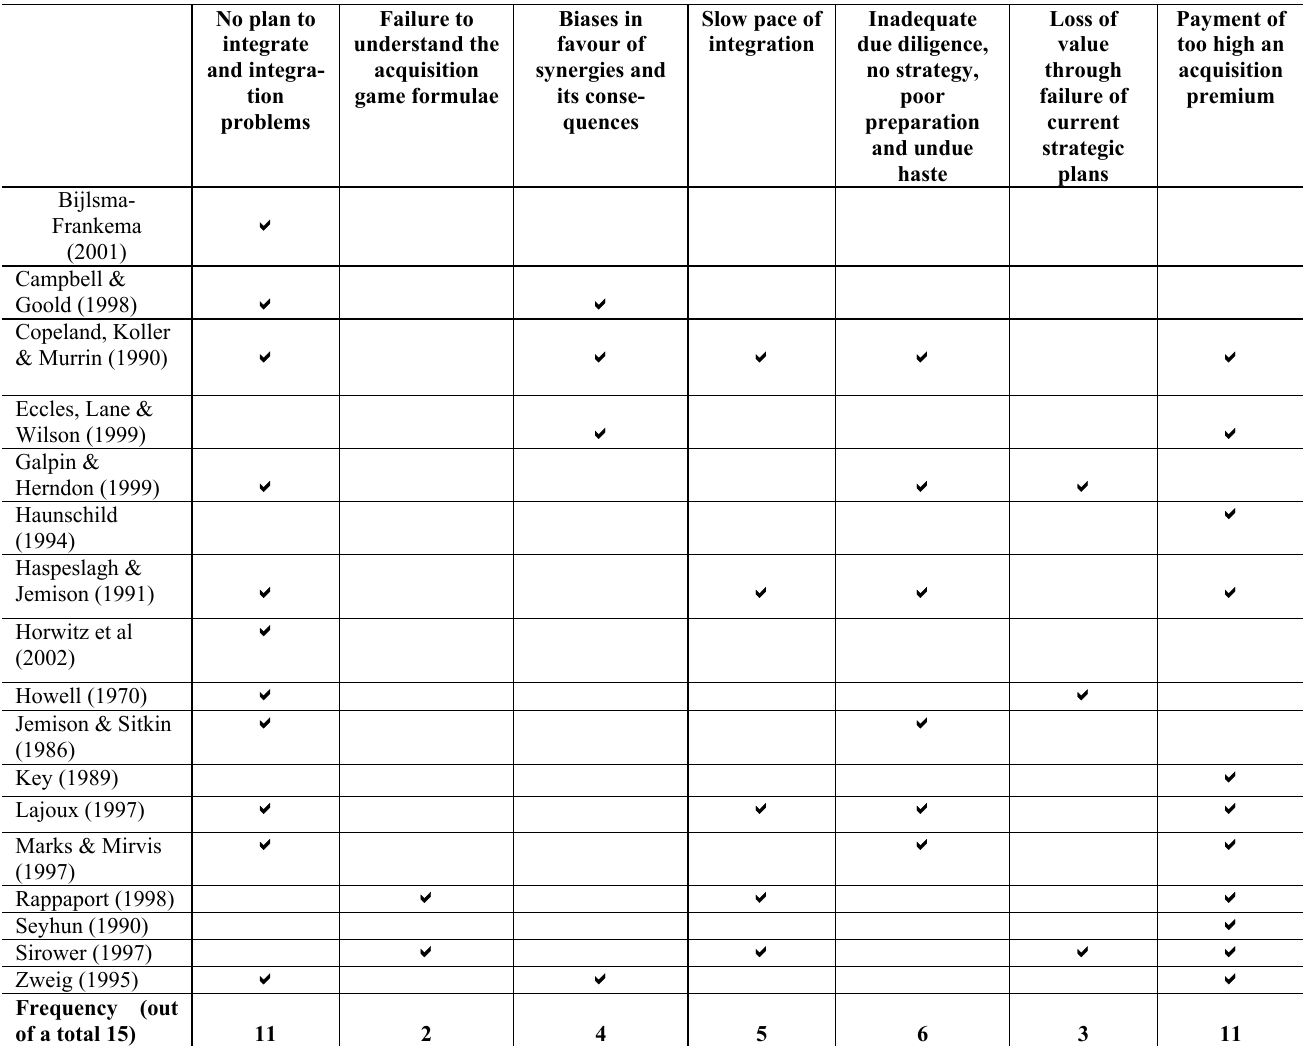
Table 1: Reasons for the failures of mergers and acquisitions